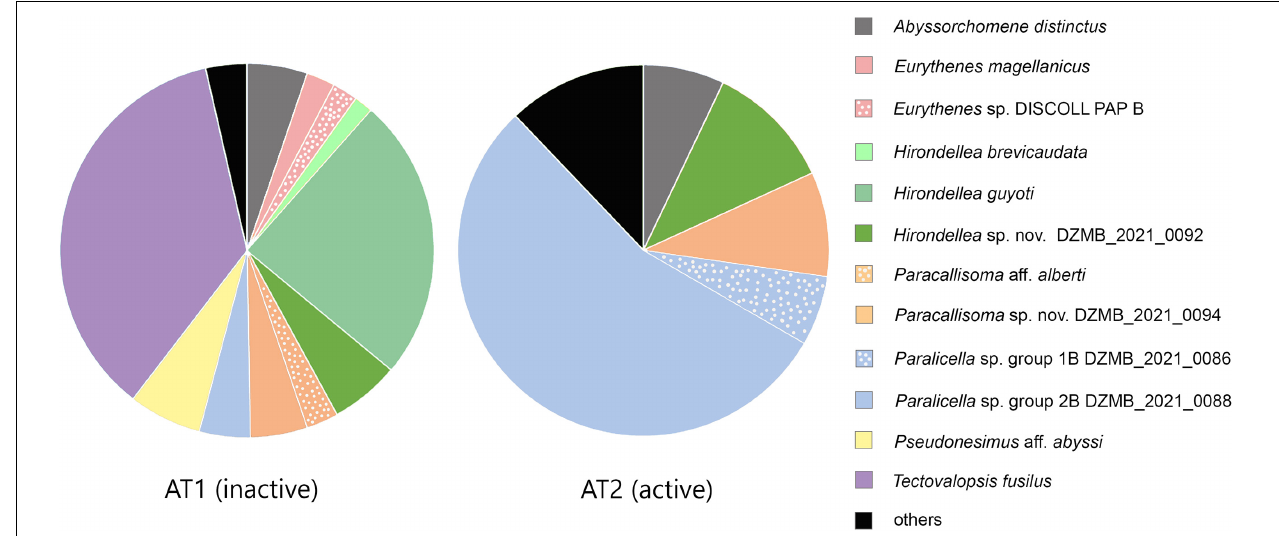
FIGURE 7 | Relative abundance of MOTUs at the active and inactive areas. Unnamed MOTUs with n ≤ 3 are grouped together as “others.” More details about numbers of each MOTU can be found in Table 3